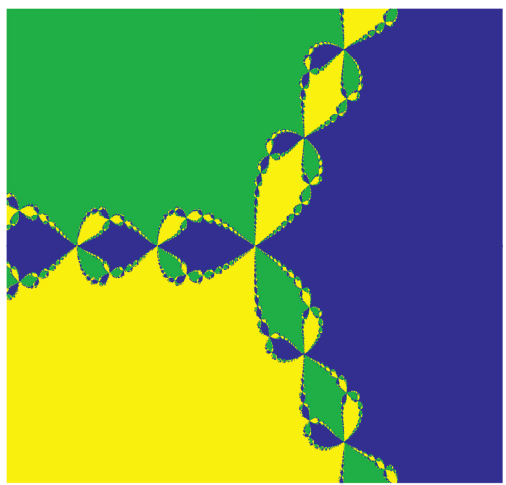
Figure 2: The global dynamics of F ( z ) � (− z 3 + 3 z 2 + 1 ) /3 z , the Newton map for f ( z ) � z 3 − 1. The blue region represents A F ( 1 ) , green represents A F ( e 2 π i /3 ) , and yellow represents A F ( e − 2 π i /3 )